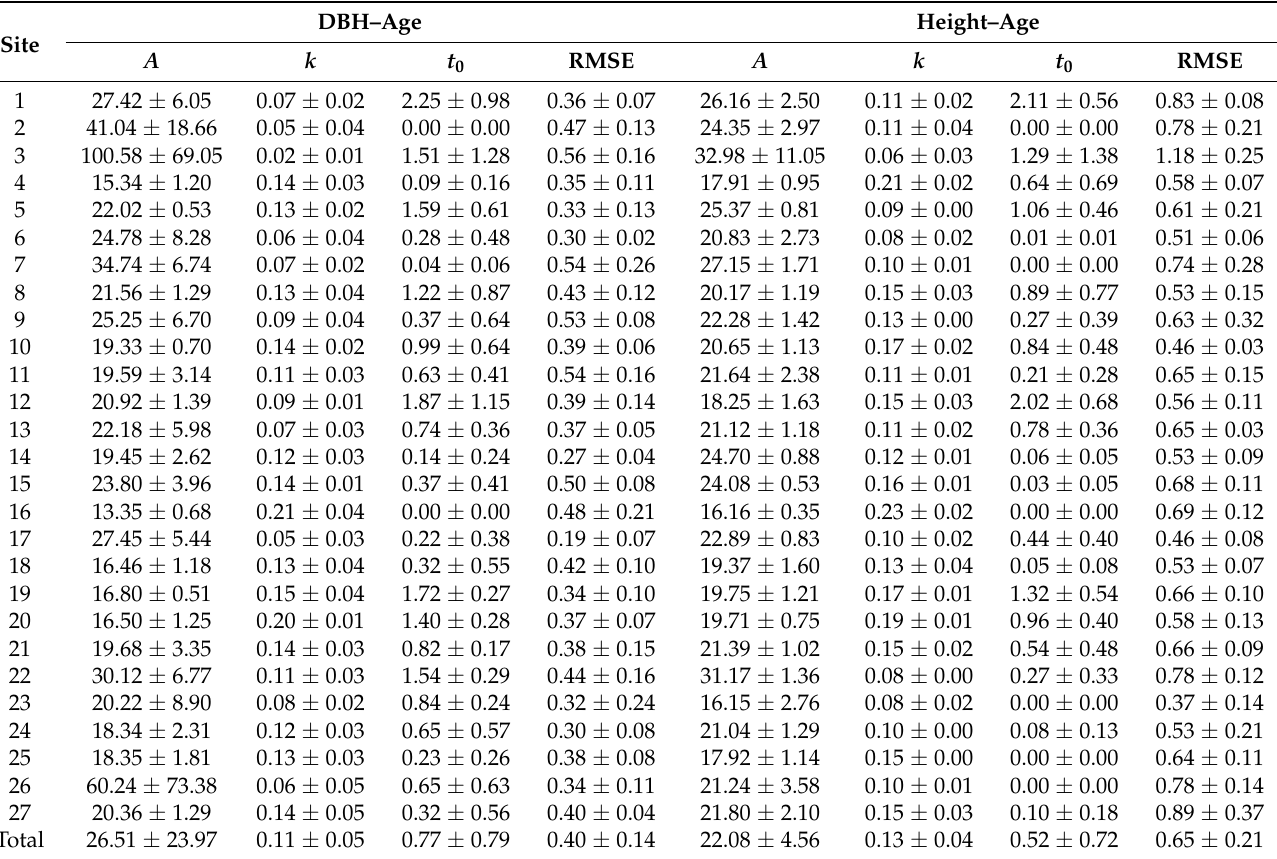
Table 1. Individual tree growth curve parameters of Mitscherlich growth function. RMSE: root mean square error. A (upper limit of tree growth), k (curvature of tree growth curve or parameter related to growth rate) and t 0 (time lag of tree growth) are fitted tree growth curve